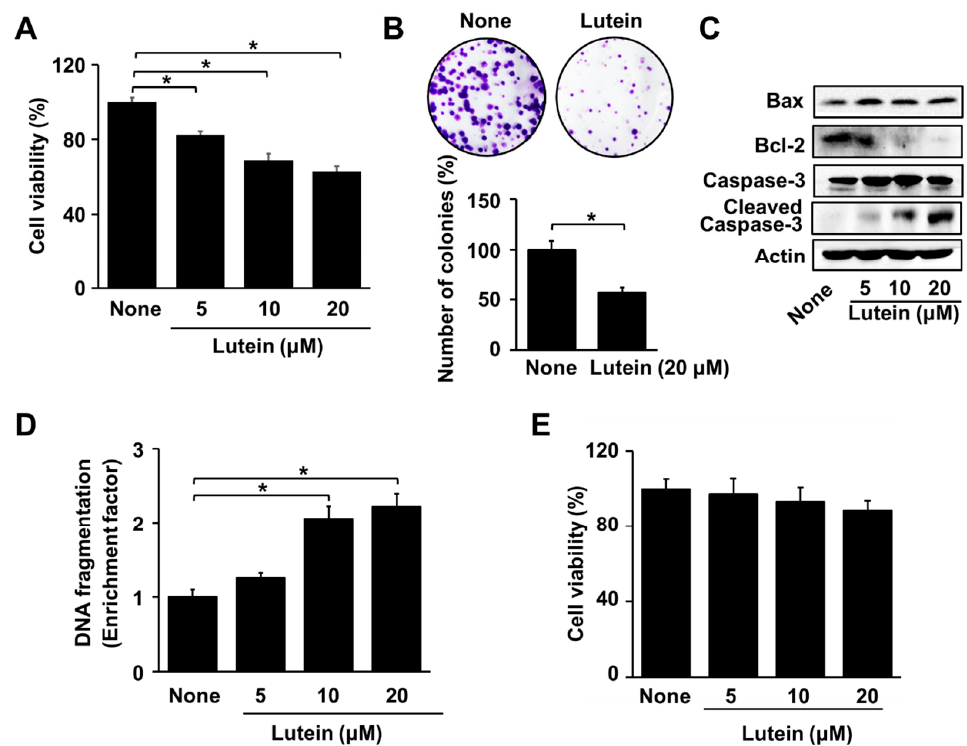
Figure 1. Effects of lutein on cell viability, colony formation, Bax and Bcl-2 levels, caspase-3 cleavage, and DNA fragmentation in AGS cells, and cell viability in RGM cells ( A ) AGS cells were treated with the indicated concentrations of lutein for 24 h. Cell viability was determined by counting the number of viable cells. The viability of untreated cells (none) was set at 100%. ( B ) AGS cells were treated with 20 µ M lutein and incubated for 2 weeks, after which the colonies were visualized by staining with crystal violet. The number of cell clones were counted using a microscope. The number of untreated cell clones (indicated as “none”) was set as 100%. ( C ) AGS cells were treated with the indicated concentrations of lutein for 24 h. The levels of Bax, Bcl-2, caspase-3, and cleaved caspase-3 in whole-cell extracts were determined by Western blotting. ( D ) AGS cells were treated with the indicated concentrations of lutein for 20 h. DNA fragmentation was assessed by the amount of nucleosome-bound DNA in the cell lysates. The level of DNA fragmentation for the untreated cells (“none”) was set as 1. * p < 0.05. ( E ) RGM cells were treated with the indicated concentrations of lutein for 24 h. Cell viability was determined by counting the number of viable cells. The viability of untreated cells (“none”) was set at 100%. * p <